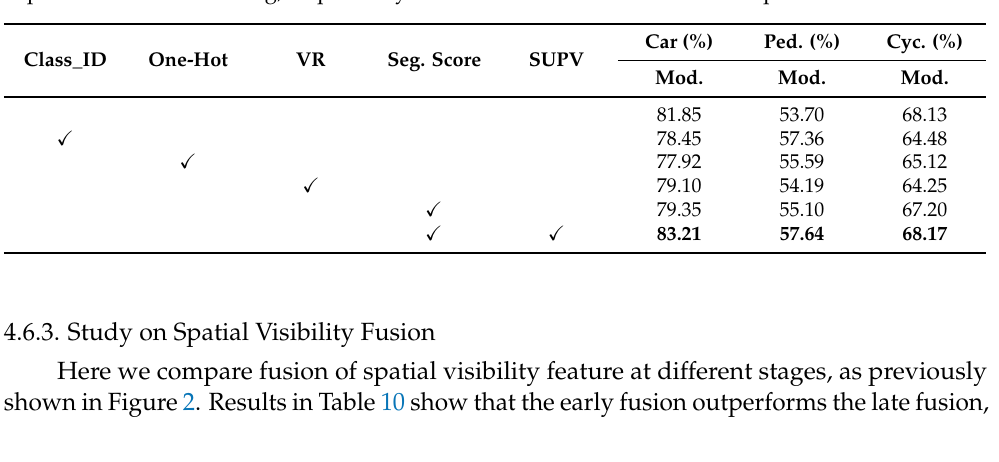
Figure 8. From top to bottom are ground truths, detection results of the SECOND, the painted SECOND and our SPV-SSD on the KITTI dataset. The ground truths and predictions are marked in blue and green respectively. Table 9. Comparison of different semantic encodings. The class_id, one-hot, VR, seg. score and SUPV denote the object category ID, one-hot encoding, VoxelRendering, segmentation score and supervised-PointRendering, respectively. The AP is calculated with 11 recall